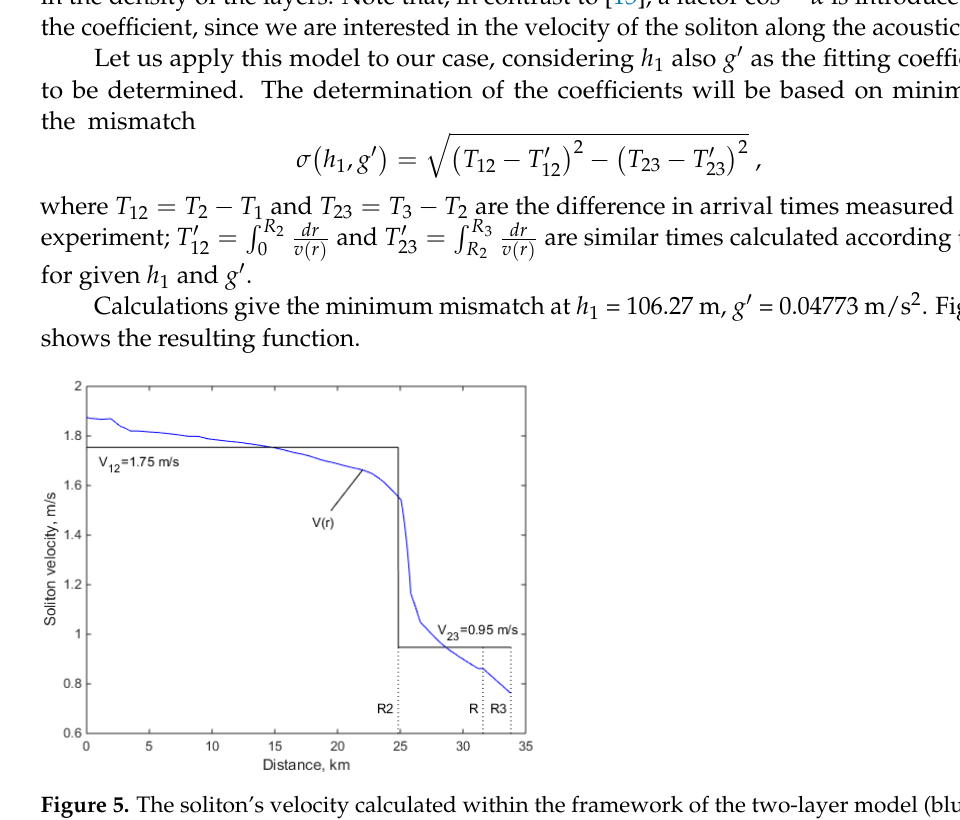
Figure 5. The soliton’s velocity calculated within the framework of the two-layer model (blue line) and average velocity in two sections (black line).